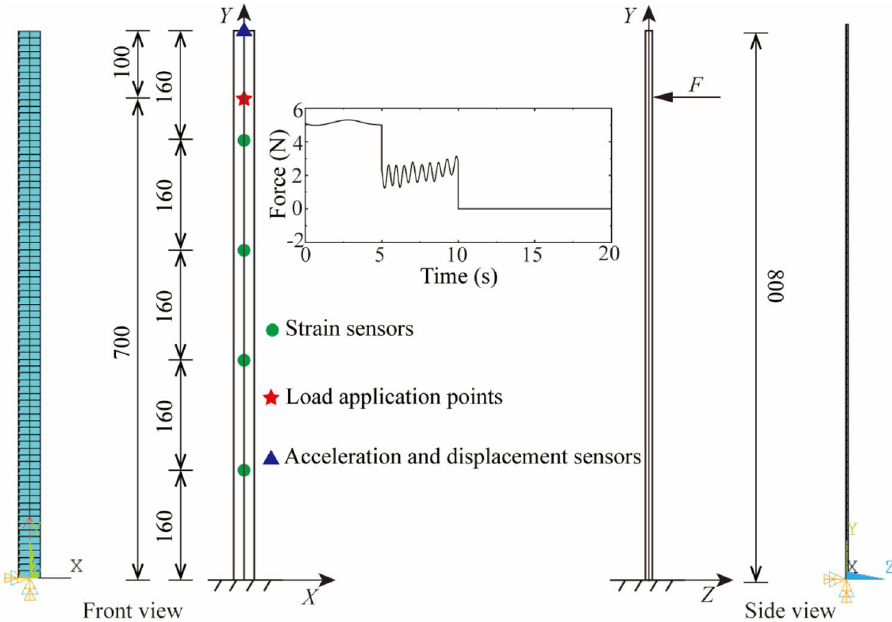
Figure 2. Finite element model and measurement point layout drawing (unit: mm).